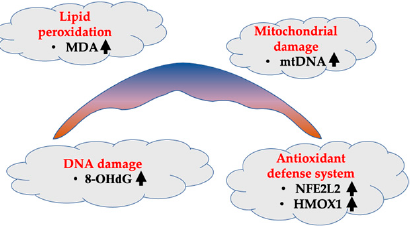
Figure 3. OS-induced changes in the placenta of a smaller twin in sFGR. Abbreviations: HMOX1, heme oxygenase 1; MDA, malondialdehyde; mtDNA, mitochondrial DNA; NFE2L2, nuclear factor erythroid 2 like 2; 8-OHdG, 8-hydroxydeoxyguanosine.